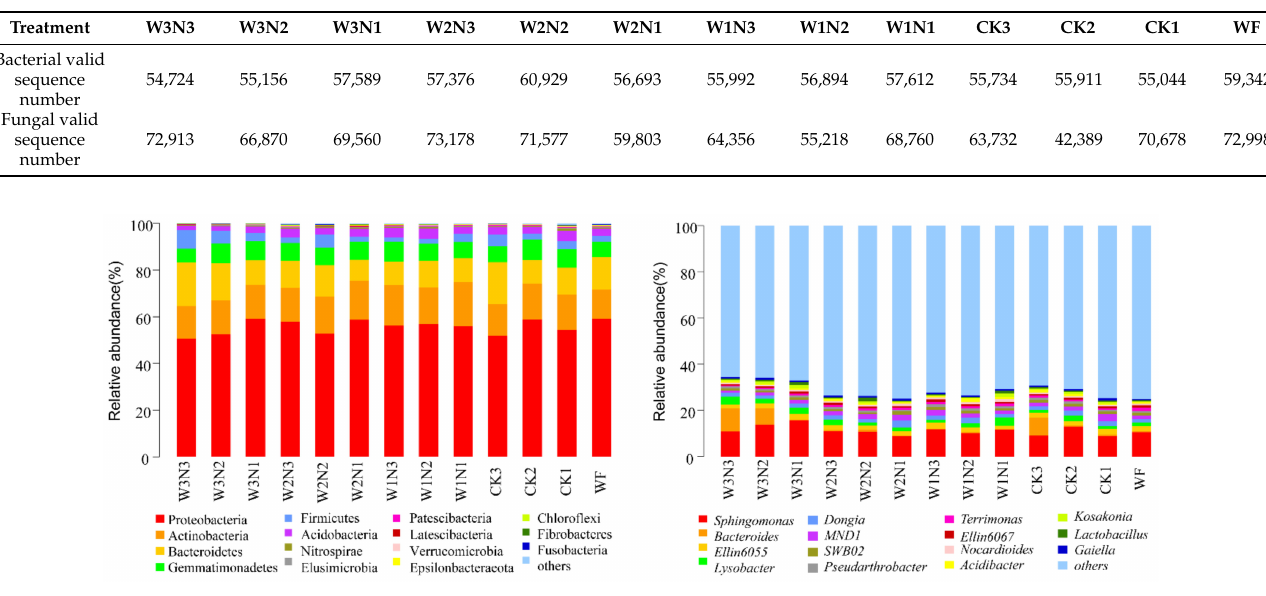
Figure 1. Differences in the taxonomic composition of soil bacteria at the phyla and genus levels.